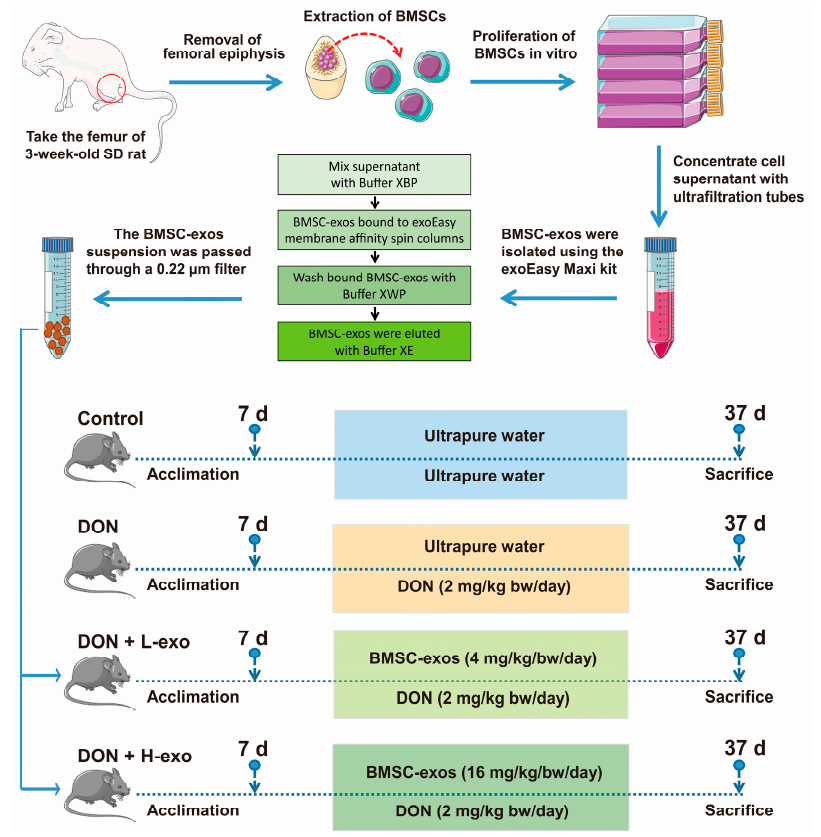
Figure 1. Experimental design and methods. All procedures for stem cell culture, exosome extraction, and experimental grouping and design of this study.